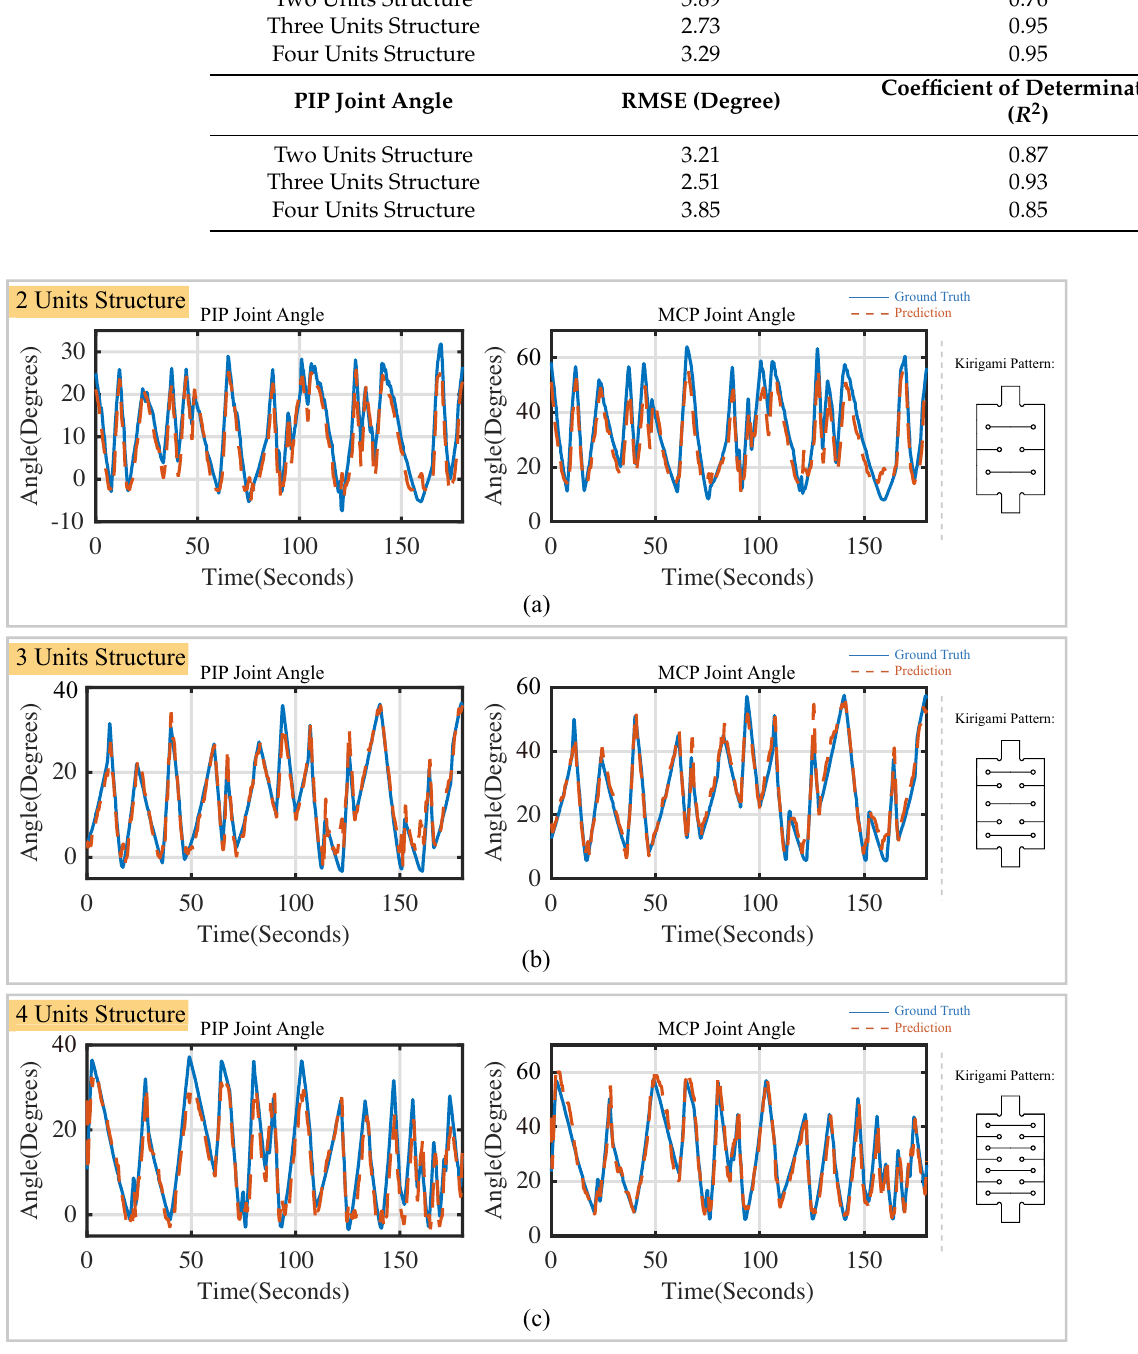
Figure 12. Performance of the LSTM calibration neural network in predicting joints angles of actuators in random motion. ( a ) Results for sensors with two-unit structure; ( b ) results for sensors with three-unit structure; ( c ) results for sensors with four-unit structure. Ground truth is indicated using a solid line. Prediction results are indicated using a dashed